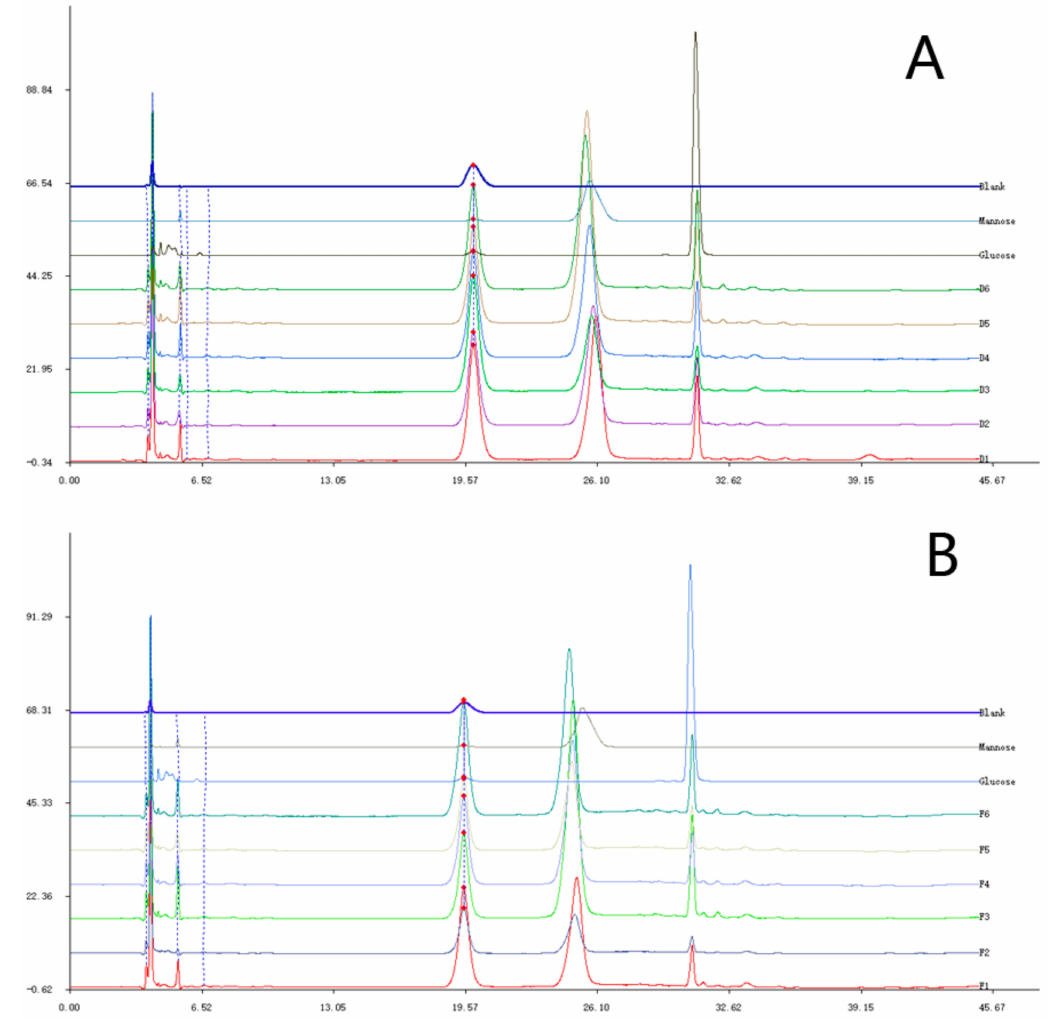
Figure 6. Monosaccharide analysis of ( A ) D1–D6 and ( B )